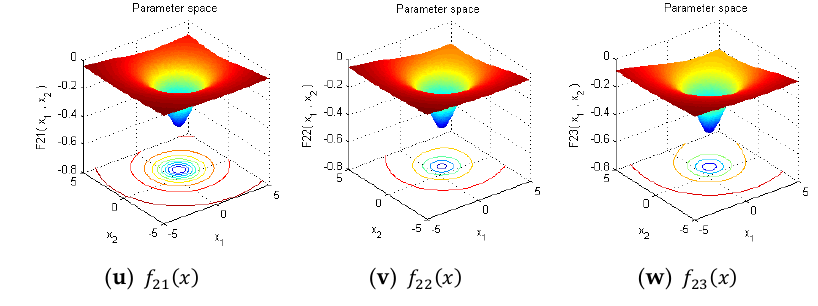
Figure 3. The 2D version of the benchmark functions. Table 4. Fixed-dimension multimodal benchmark